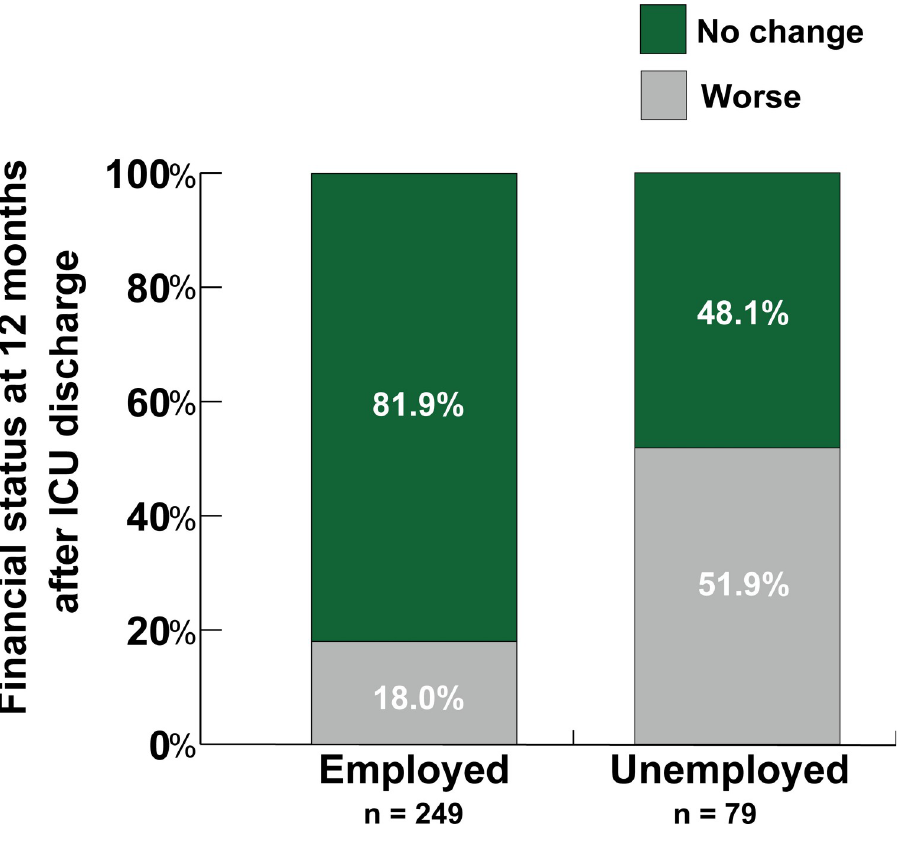
Fig 3. Perceived change in household financial status before and after ICU admission.